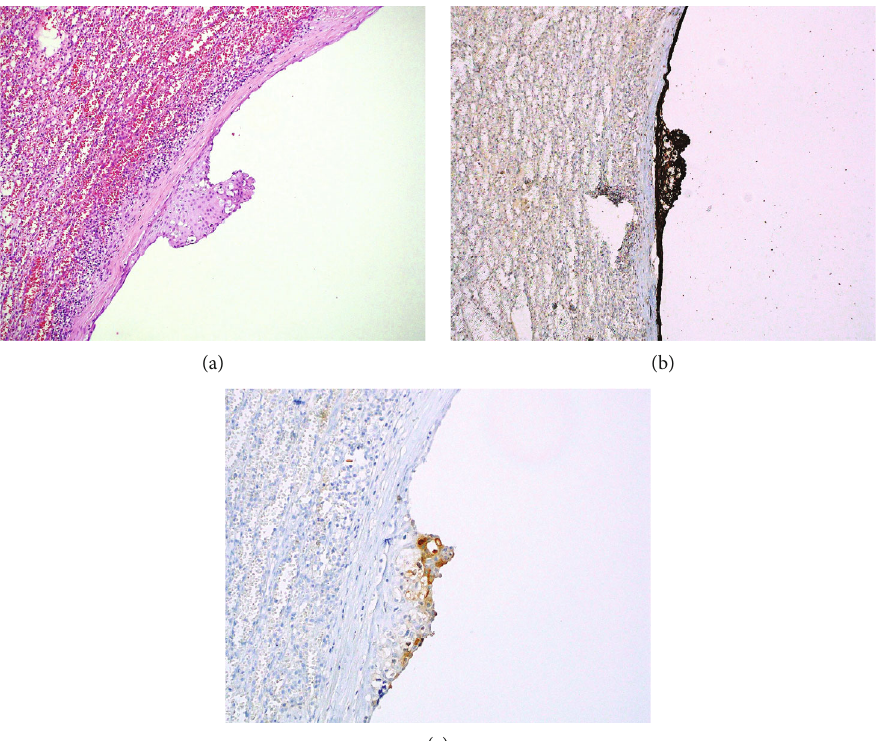
Figure 3: (a) Splenic epidermoid cyst with strati fi ed squamous epithelial with focal mucous cells and simple fl at mesothelial cell cyst lining (H&E 100 magni fi cation; 10x). (b) CK5/6 IHC marking both strati fi ed squamous epithelial and simple fl at mesothelial cell lining cells (100